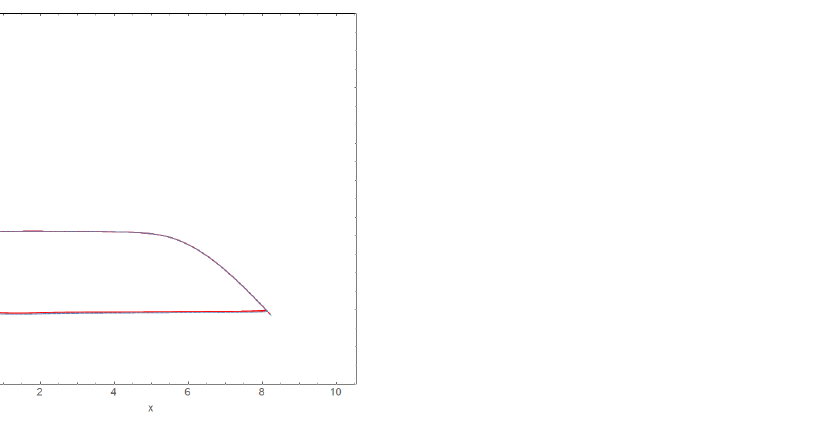
Figure 5. Phase space: the dashed blue curve shows the orbit of System (7) while the red full curve shows the orbit of System (5).